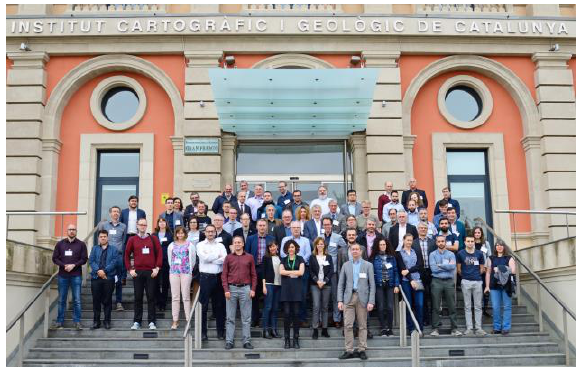
Figure 17. Attendees at the EuroSDR Workshop on SP/GM lidar, Barcelona, Spain on 6 th March